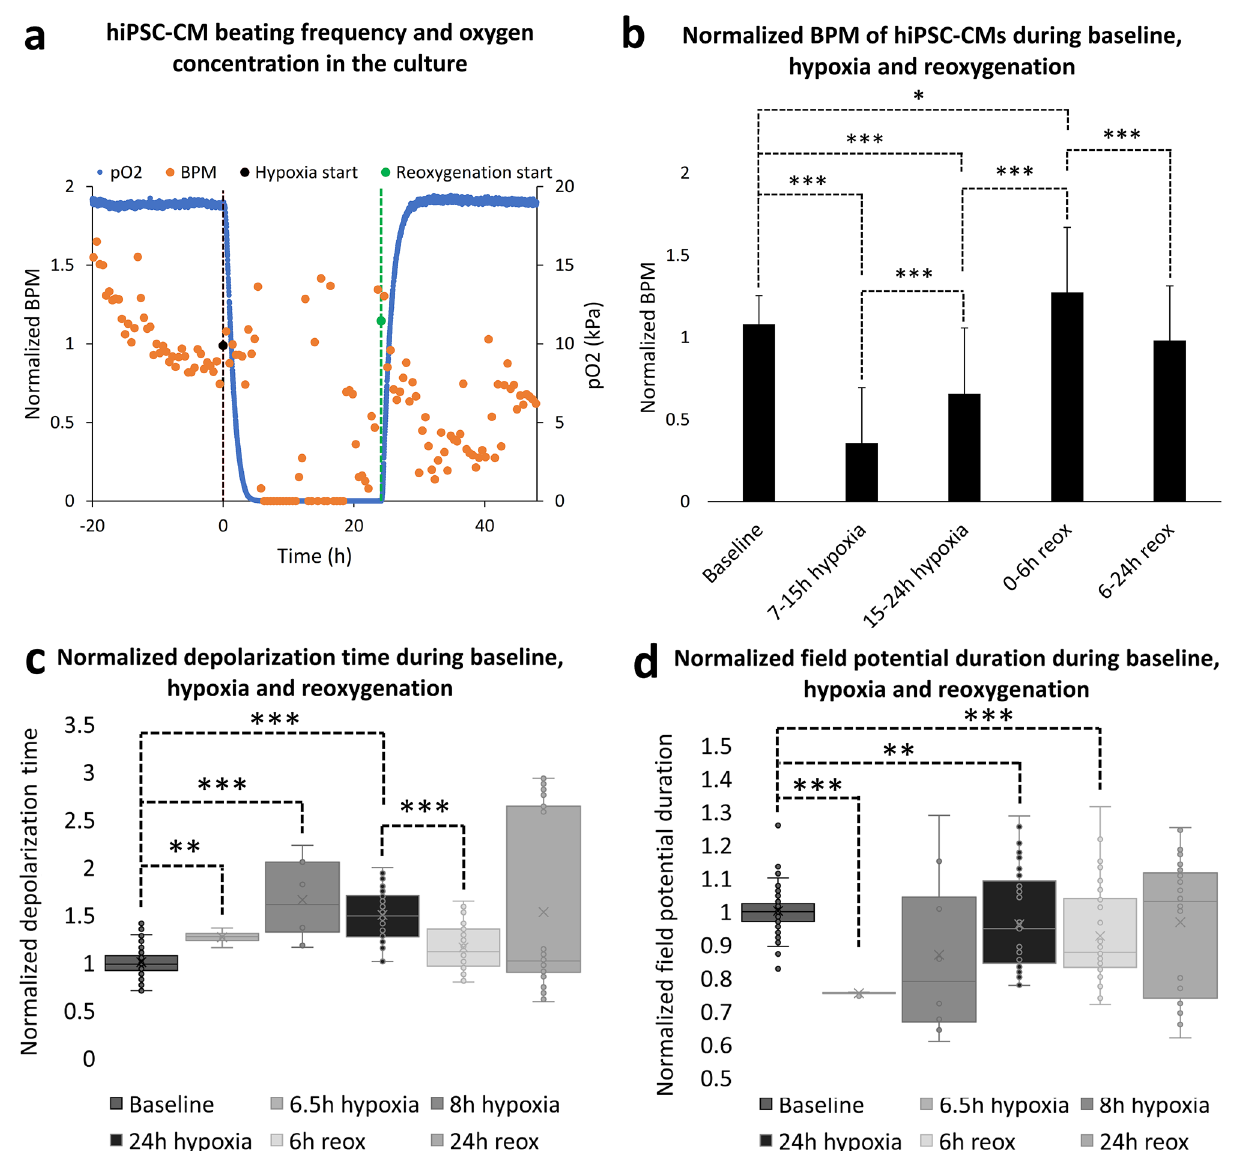
Figure 1. ( a ) Representative measurement of the partial pressure of oxygen and normalized beating frequency from a single experiment. Black line marks the initiation of hypoxia, after which the oxygen level of the culture starts to decrease and reaches 0 kPa approximately within 4 h. Green line marks the initiation of reoxygenation, after which the oxygen level starts to increase and reaches 19 kPa approximately within 4 h of reoxygenation. The beating frequency of the hiPSC-CMs clearly decreases during hypoxia and increases after reoxygenation. ( b ) The mean normalized beating frequency extracted from MEA recordings for hiPSC-CMs during baseline measurement, 7–15 h hypoxia, 15–24 h hypoxia, 0–6 h reoxygenation and 6–24 h reoxygenation presented as mean + standard deviation (n electrodes = 41). Normalization is done to each electrode separately with regard to median baseline value, due to the variation observed in the beating frequency between different electrodes during baseline measurements. The beating frequency starts to decrease after hypoxia is initiated and was observed to be on its lowest during 7–15 h of hypoxia. The beating frequency started to recover already before reoxygenation was initiated and was statistically significantly greater during 15–24 h hypoxia compared to 7–15 h hypoxia. Furthermore, overcompensation in the beating frequency was observed during 0–6 h of reoxygenation, when the mean normalized beating frequency exceeded the baseline. After 6 h reoxygenation, the beating frequency returned close to the baseline level. ( c ) Normalized depolarization time of hiPSC-CMs at baseline, 6.5 h, 8 h and 24 h hypoxia as well as 6 h and 24 h reoxygenation. Depolarization time increased during hypoxia and returned close to the baseline level during reoxygenation. ( d ) Normalized field potential duration (FPD) of hiPSC-CMs at baseline, 6.5 h, 8 h and 24 h hypoxia as well as 6 h and 24 h reoxygenation. FPD decreased during hypoxia and returned close to the baseline level during reoxygenation *p < 0.05, **p < 0.01, ***p <